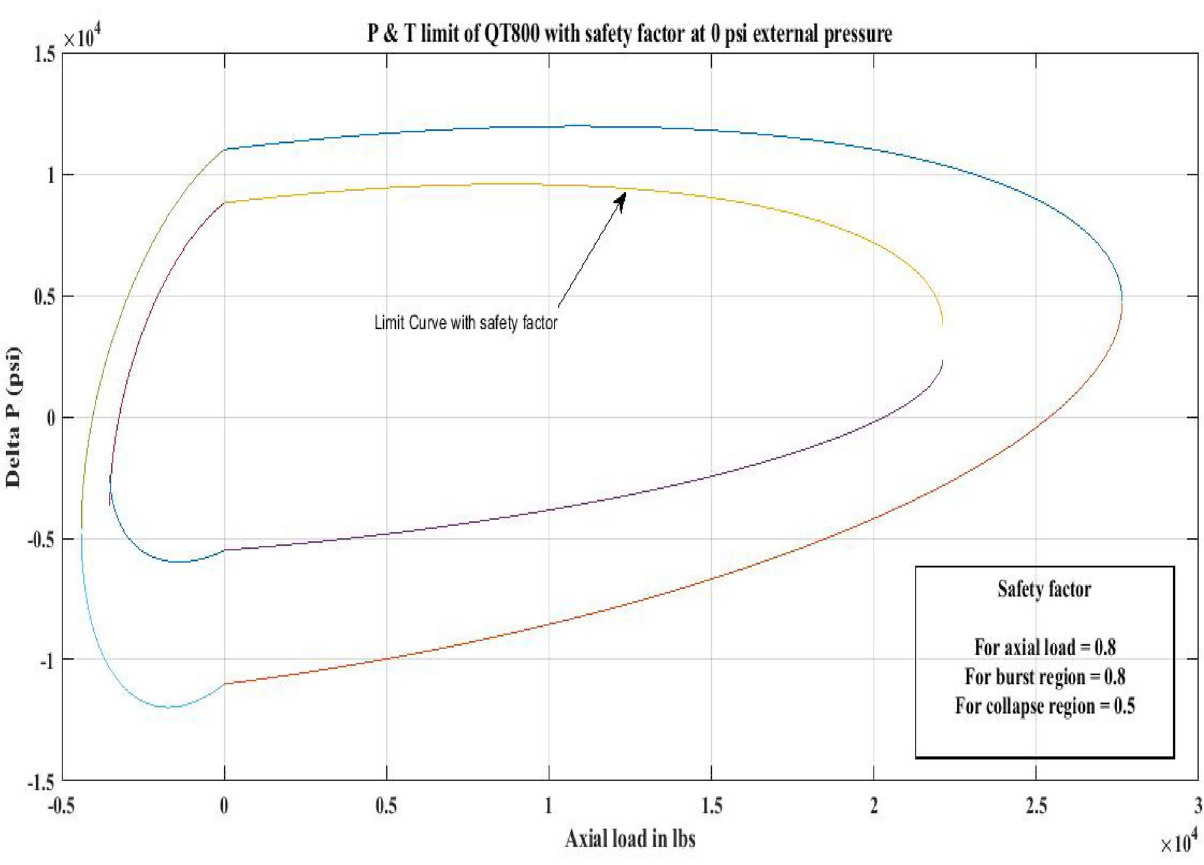
Figure 16. P and T limit with safety factor for QT 800 at 0 P o .